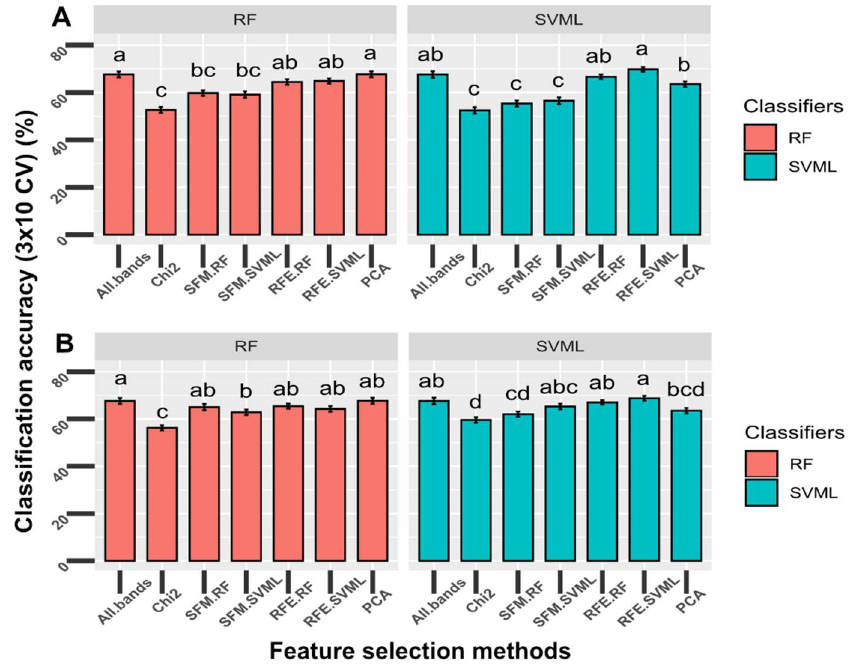
Figure 5. Comparison of the performance of the original top 10 selected wavelengths ( A ) and top 10 features with a minimum of 20 nm distance ( B ) by different feature-selection methods to classify the mock-inoculated healthy peanut plants and plants inoculated with Athelia rolfsii at different stages of disease development (input data = all five classes). Feature selection methods tested: Chi2 = SelectKBest (estimator = chi-square); SFM-RF = SelectFromModel (estimator = random forest); SFM-SVML = SelectFromModel (estimator = support vector machine with linear kernel); RFE-RF = Recursive feature elimination (estimator = random forest); RFE-SVML = Recursive feature elimination (estimator = support vector machine with linear kernel). The top 10 components were used as input data for the principal component analysis (PCA) method. The two classifiers tested: RF = random forest; SVML = support vector machine with the linear kernel. Bars with different letters were statistically different using nonparametric Friedman and Nemenyi tests with an α level of 0.05. Error bars indicate standard deviation of accuracy using stratified 10-fold cross-validation repeated three